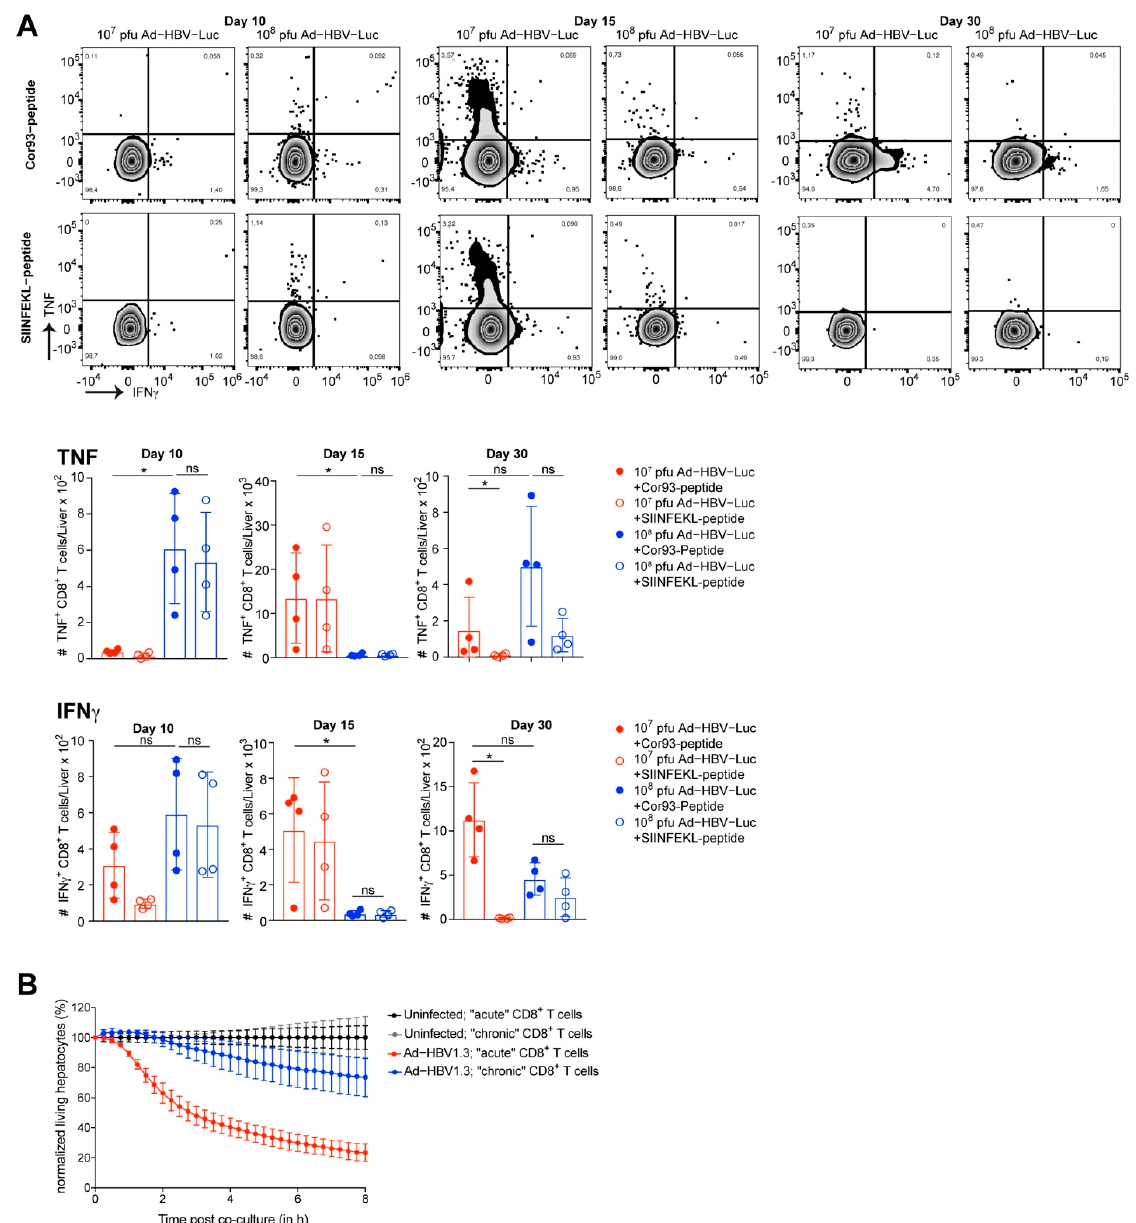
Figure 4. Functionality of endogenous intrahepatic HBV-specific CD8 T cells. ( A ) Lymphocytes were isolated from livers of C57Bl/6 mice infected i.v. with the acute self-limited (10 7 pfu, red) or chronic infectious dose (10 8 pfu, blue) of Ad-HBV-Luc. ( A ) Flow cytometric analysis and quantification of numbers of TNF and IFN γ expressing intrahepatic CD8 T cells following restimulation by HBcAg-derived Cor93 peptide or SIINFEKL peptide as control (gated on bulk living CD8 T cells) at day 10, 15 and 30 post infection. ( B ) Co-culture of primary murine hepatocytes infected with Ad-HBV1.3 and intrahepatic CD8 T cells isolated from mice infected as in ( A ) (target to effector ratio: 1 to 50). Hepatocytes were infected with MOI of 5. CD8 T cells were isolated at day 15 post infection. Lysis of target cells was detected by xCELLigence technology. Mean and SD are shown: ( A ) n = 4, ( B ) n = 5. The experiments were performed once ( A ) or twice ( B ).